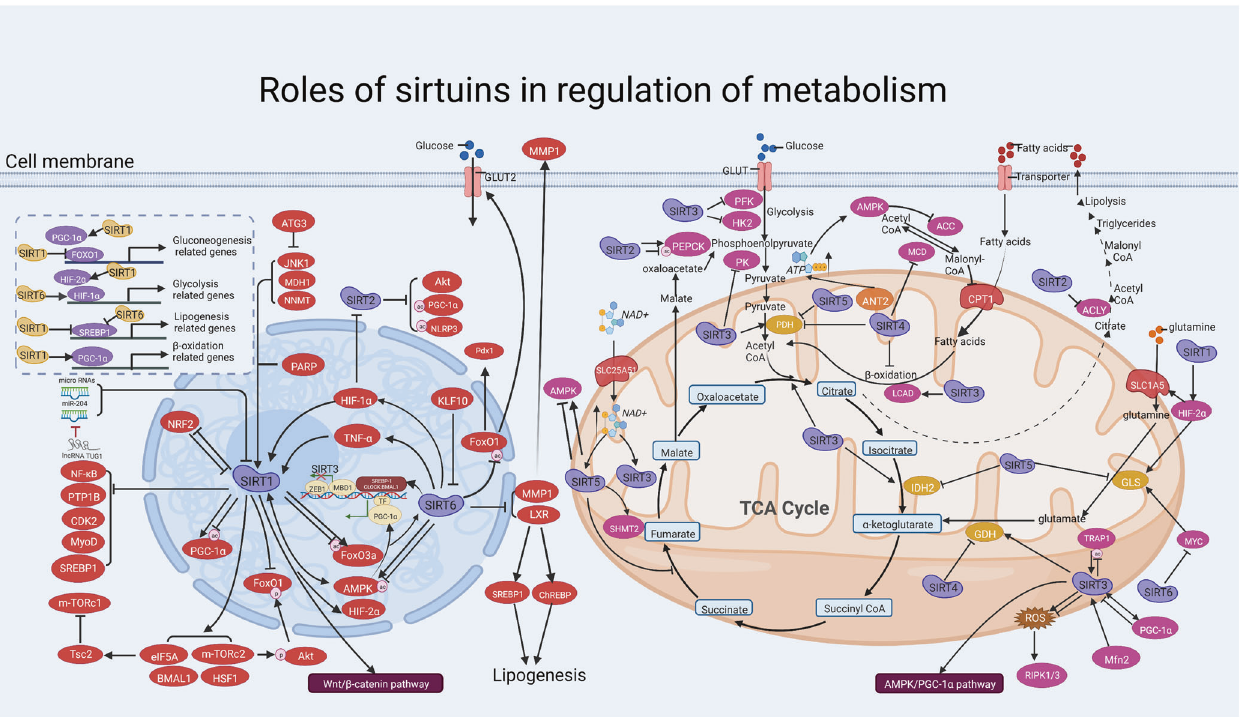
Fig. 3 Overview of the roles of SIRTs in cell metabolism. SIRTs participate in glucose metabolism, lipid metabolism, and other metabolisms via interacting with metabolism-related genes and enzymes. (i) In the nuclear, SIRT1 and SIRT6 activate the transcription factors HIF2 α and HIF1 α respectively through different manners and subsequently improve glycolysis. Besides, SIRT1 regulates gluconeogenesis by activating PGC1 α and inhabiting FOXO1, thereby affecting the transcriptional activation of their target genes. SIRT1 also promotes fatty acid oxidation by activating PGC1 α and promoting the expression of target genes. Besides the positive regulation, SIRT1 and SIRT6 suppress SREBP1 and transcriptionally represses lipogenesis. (ii) In cytoplasm, SIRT2 deacetylates and activates the rate-limiting enzyme PEPCK and promotes gluconeogenesis during low nutrient condition. Moreover, SIRT2 inhabits ACLYand deters lipid synthesis. (iii) Regarding SIRTs in mitochondria, SIRT4 and SIRT5 reduces PDH activity which converts pyruvate to acetyl CoA. Both SIRT3 and SIRT4 target GDH, but their enzymatic activities are opposite. Besides GDH, SIRT3 also improves IDH2 and LCAD activity, thus enhancing cellular respiration and stimulating β -oxidation of fatty acids. Moreover, SIRT5 represses IDH2 activity and may disrupt glutamine metabolism through GLS. Activation and inhibition effects are displayed in “ arrows ” and “ inhibitors ” , respectively. https://biorender.com. ACC acetyl-CoA carboxylase, ACLY ATP citrate lyase, ANT2 adenine nucleotide translocase 2, Bmal1 brain-muscle-Arnt-like protein-1, CDK2 cyclin-dependent kinase 2, ChREBP carbohydrate response